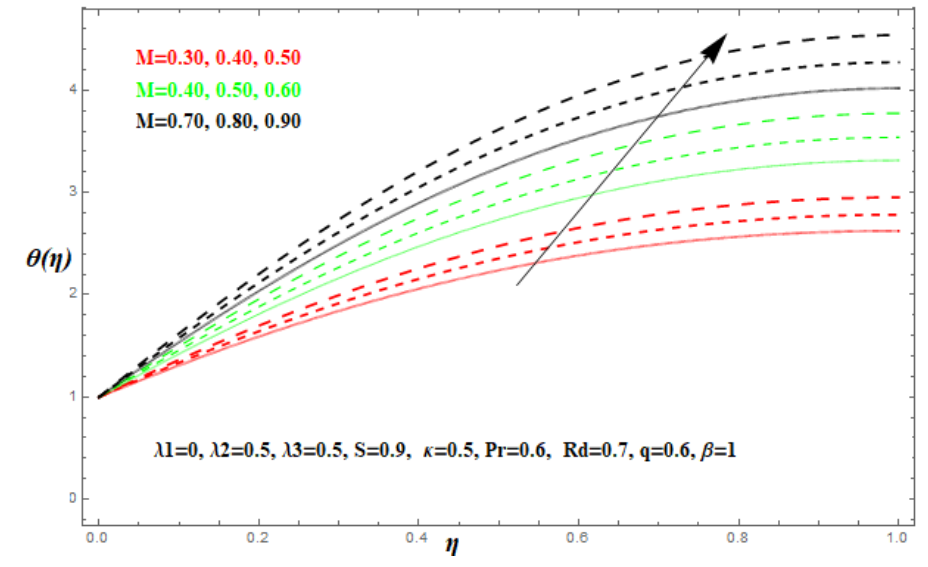
Figure 7. Changes in temperature gradient 𝜃(𝜂) for diverse measures of 𝛭